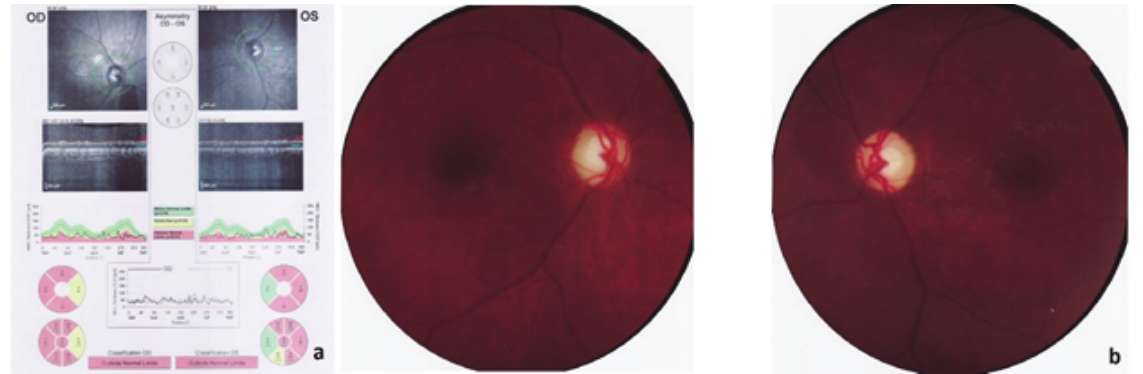
Figure 6. Severe optic atrophy with disc paleness in both eyes of case